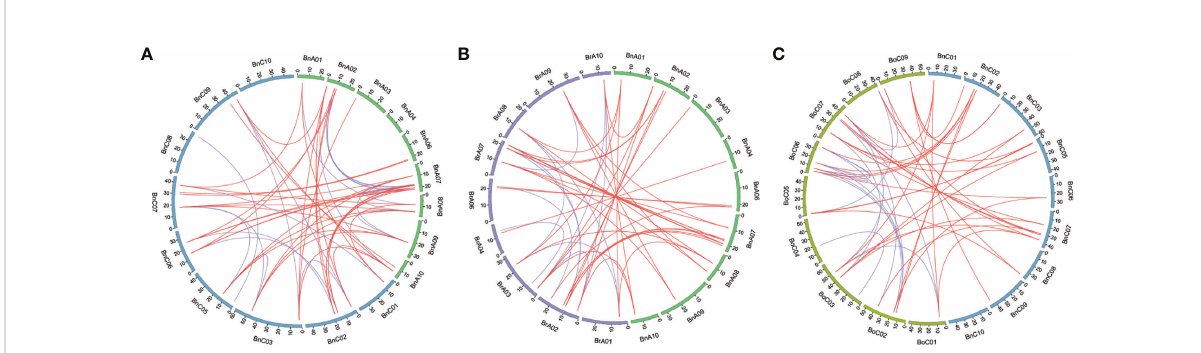
FIGURE 5 Genome-wide synteny analysis for CLE s among Brassica napus , Brassica rapa , and Brassica oleracea . (A) Synteny analysis of CLE s on An and Cn subgenomes in B. napus . (B) Synteny analysis of CLE s between A n subgenome of B. napus and B. rapa. (C) Synteny analysis of CLE genes between Cn subgenome of B. napus and B. oleracea . Inside the circos, brown lines linked the syntenic orthologs, and blue lines linked the syntenic